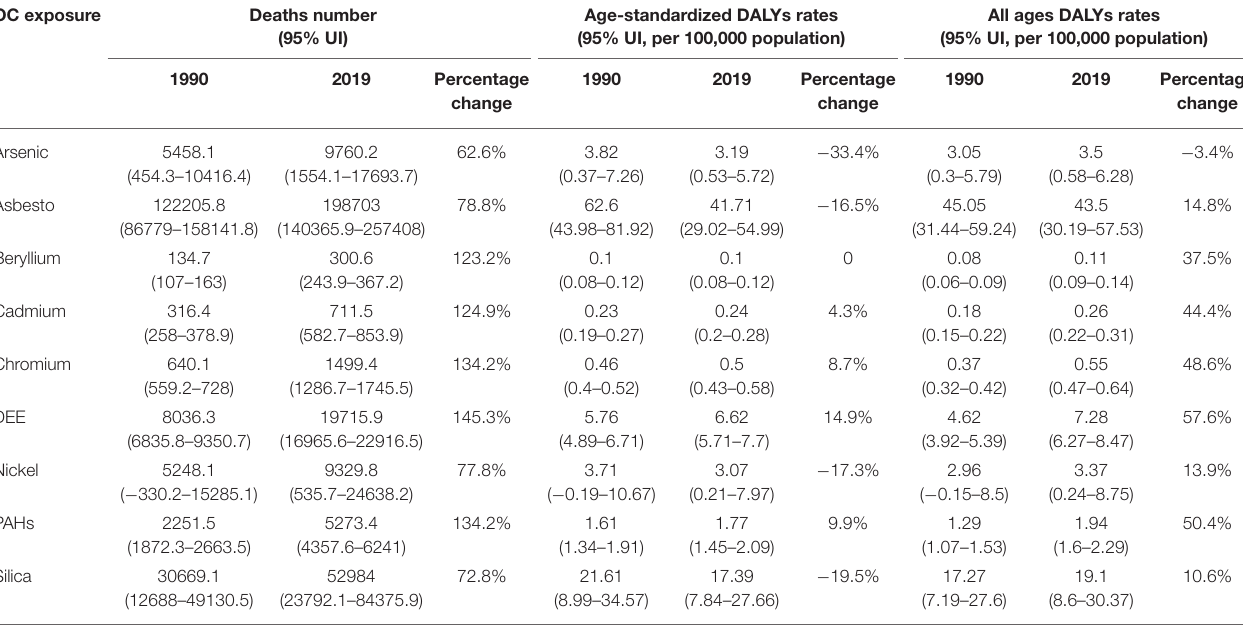
TABLE 1 | Global all age deaths, age-standardized and all ages DALY of patients with TBL cancer attributable to 9 OCs for both sexes, 1990–2019. OC